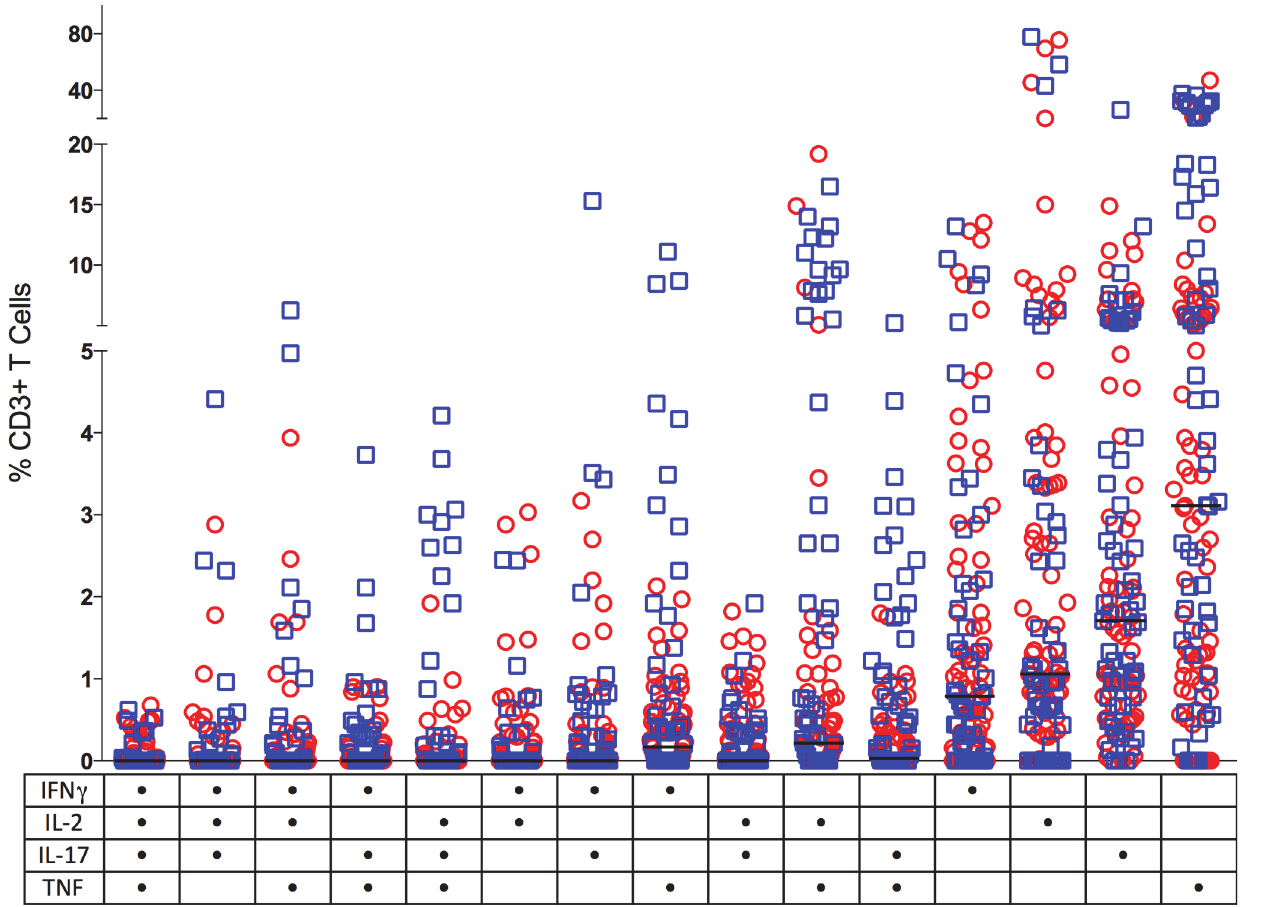
Figure 5. CD3+ T cells making single (one) or multiple (two, three or four) cytokines from individual granulomas. Non-sterile granulomas are in open circles (red) and sterile granulomas are represented as open squares (blue). Solid line indicates median response. The table on the X axis reflects the groups positive for each cytokine represented by a dot. There was no significant difference between the multiple cytokine pattern of response between sterile and non-sterile granulomas or between various clinical states of the animal. (n = 121).